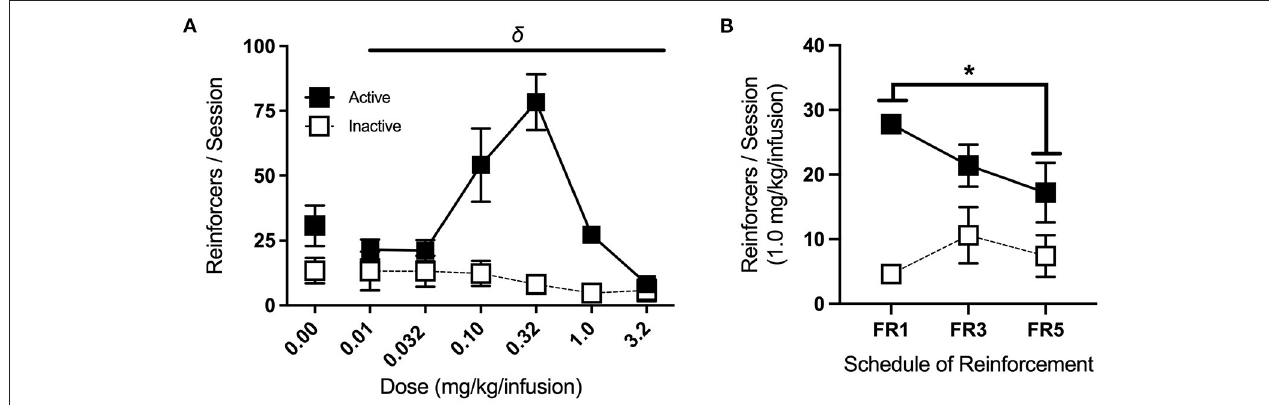
FIGURE 8 | Dose-response and increasing cost schedule. (A) Average nose-pokes (active port, large boxes; inactive port, and small boxes), excluding those made during time-out periods, during dose-response testing. There was a significant effect of dose on active port responses (indicated by δ ), with responses for the 0.32 mg/kg/infusion dose being significantly greater than those at the 0.01, 0.032, 1.0, and 3.2 mg/kg/infusion doses (n/group = 9). (B) Average nose-pokes across increasing schedules of reinforcement for the acquisition dose, with mice making fewer responses at the active port in FR5 sessions compared to FR1 sessions (n/group = 5). δ p < 0.001, * p < 0.05; data shown are mean ± SEM. Modified from Huebschman et al., 2021, with permission from Wiley and the Federation of European Neuroscience Societies. The figures include data collected with support from the NIDA Drug Supply Program (gifted drug) and Texas A&M University